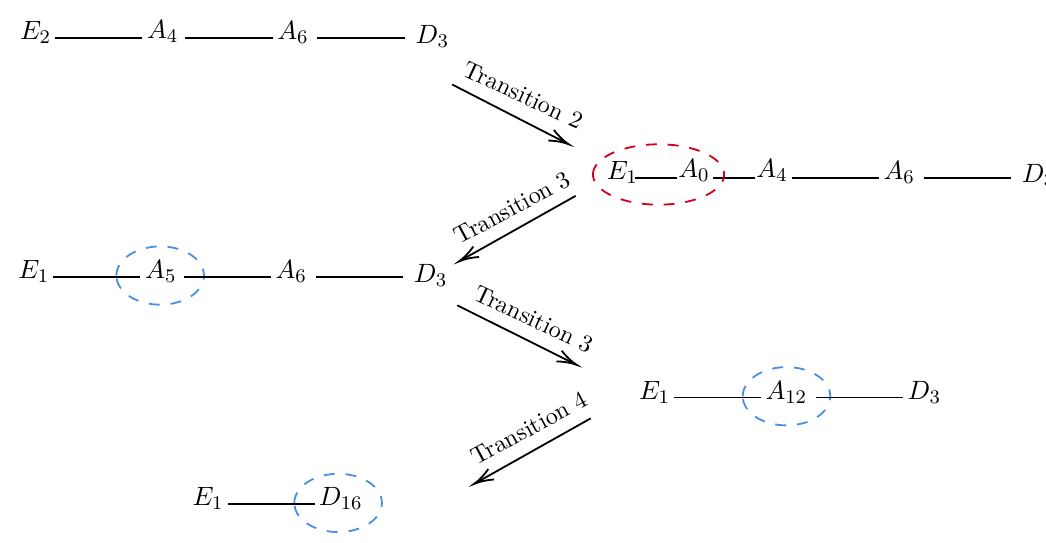
Figure 3 . The above graph demonstrates the algorithm to deform a theory consistent with the condition (3.7) to a maximally enhanced theory in table